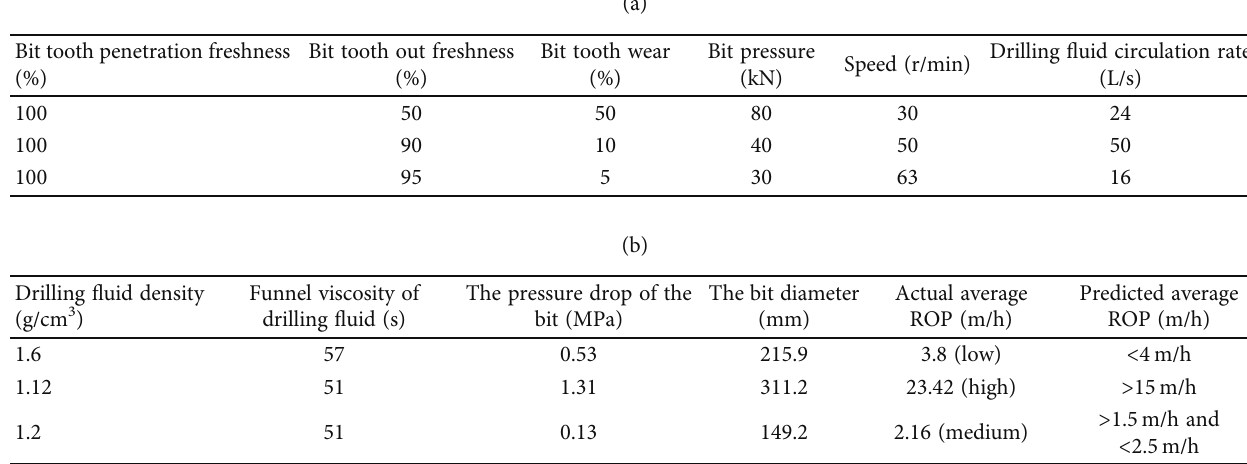
Table 10: Comparison of predicted ROP data and actual ROP